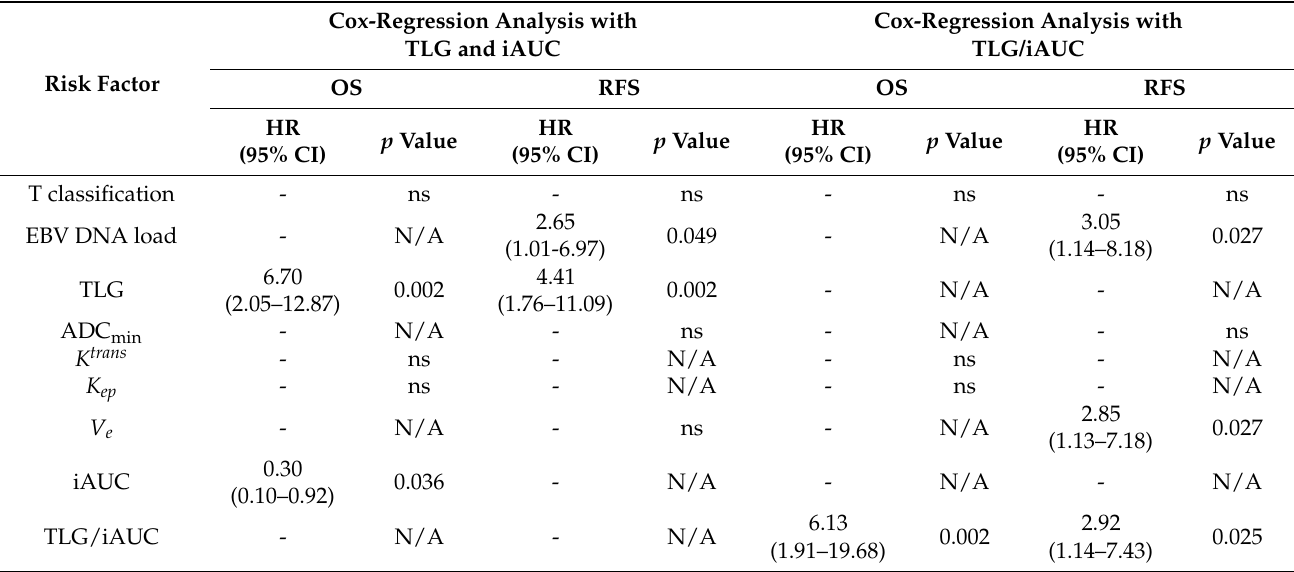
Table 3. Multivariate cox-regression analysis of clinical factors and imaging biomarkers relative to overall survival and recurrence-free survival.